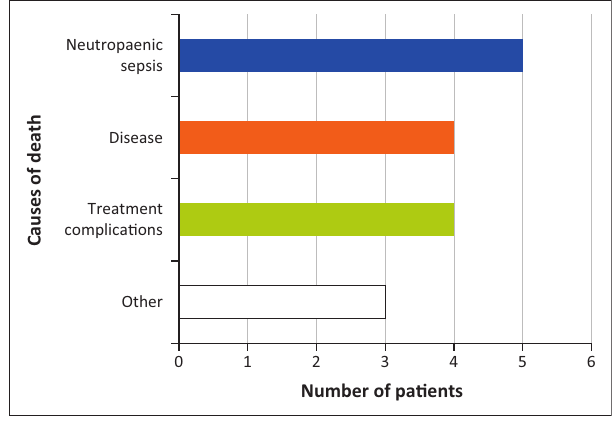
FIGURE 1: Indications for admission of oncology patients to paediatric intensive care unit.